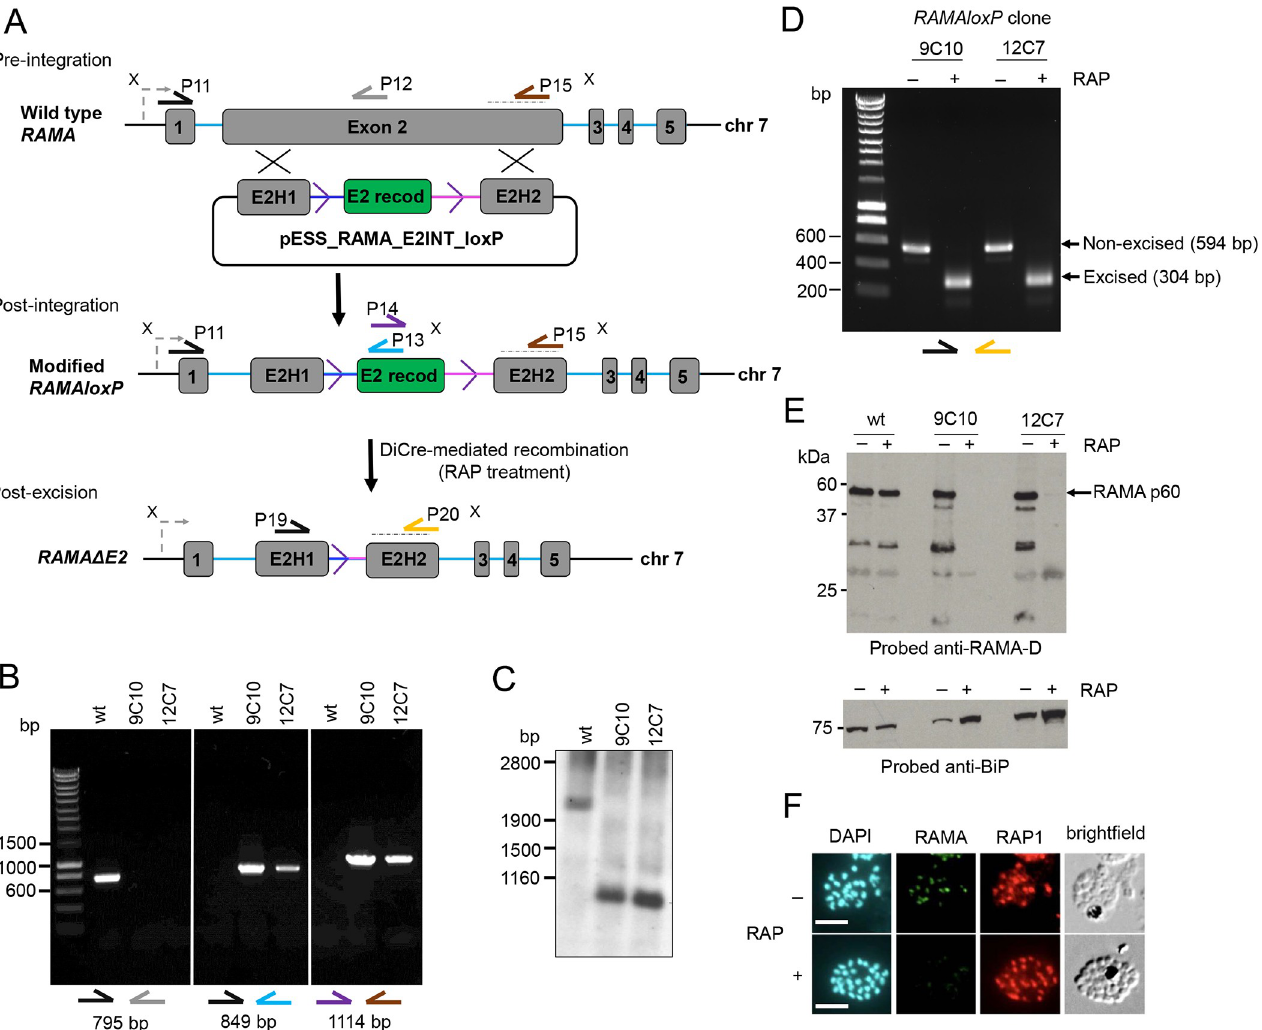
Fig 1. Conditional disruption of the P . falciparum RAMA gene. (A) The RAMA gene (PlasmoDB PF3D7_0707300) comprises 5 exons (numbered grey boxes; not to scale) and 4 introns (blue lines). Two AG-AT motifs (splice site junction consensus sequences; [72]in exon 2, separated by 176 bp, were chosen as the location for insertion of two loxP -containing (purple arrowhead) heterologous introns ( SERA2 : loxPint ,blue line; SUB2 : loxPint ,pink line) flanking a recodonised form of the intervening 176 bp coding sequence (E2 recod, green box). The integration sequence, provided on repair construct pESS_RAMA_E2INT_loxP, was inserted by double crossover homologous recombination between homology arms (E2H1 and E2H2), facilitated using Cas9 and sgRNAs encoded on a separate plasmid to generate a targeted double stranded break (see Materials and methods). DiCre-mediated recombination between the loxP sites in the modified RAMAloxP locus was expected to excise the E2 recod sequence, leaving only a single chimeric SERA2 : loxP : SUB2 intron on the chromosome and generating a frame-shift following the first 220 amino acid codons of the RAMA coding sequence. Positions of primers used for diagnostic PCR are indicated (half arrows; see S1 Table for numerical codes and sequences of all primers used in this study), as are XmnI restriction sites (X) used for Southern blot analysis. The grey dotted line indicates the region used for hybridisation of a probe for Southern blot. (B) PCR analysis of RAMAloxP clones 9C10 and 12C7 confirmed the expected gene modification events. Amplicons diagnostic of the wild type locus obtained from parental 1G5DC parasites (wild type; wt) were not amplified from the RAMAloxP clones. Primer identities are colour-coded as in panel (A). (C) Southern blot; XmnI-digested genomic DNA from RAMAloxP clones 9C10 and 12C7 was hybridised with a probe specific for the E2H2 sequence. Expected fragment sizes are 2,191 bp (wt) and 1,050 bp ( RAMAloxP ).(D) Diagnostic PCR showing efficient RAP-induced excision of the floxed sequence in the RAMAloxP parasite clones, leading in both cases to the expected decrease in amplicon size from 594 bp to 304 bp. Primer identities are colour-coded as in panel (A). (E) Immunoblots of SDS PAGE-fractionated cycle 0 schizont extracts probed with anti-RAMA-D antibodies (raised against residues 482–758 of the RAMA sequence; [36]). Loss of RAMA p60 expression (arrowed) was almost complete in the RAP-treated RAMAloxP parasites. Similarly-treated 1G5DC schizonts (wt) were analysed in parallel to confirm that RAP-treatment has no effect on RAMA expression in the absence of the RAMAloxP modification. The blots were stripped and re-probed with anti-BiP antibodies as a loading control (lower panels). (F) Representative IFA images demonstrating loss of RAMA expression upon RAP-treatment of RAMAloxP- 9C10 parasites. Cycle 0 schizonts were co-stained with anti-RAMA-D antibodies and the anti-RAP1 monoclonal antibody (mAb) 4F3. 4,6-diamidino-2-phenylindole (DAPI) was used as a DNA stain. The great majority of RAP- treated parasites ( > 99.8% as calculated from exhaustive examination of 1,002 schizonts by IFA) showed no detectable anti-RAMA-D staining, but the RAP1 signal remained unaffected. Scale bars, 5 μ m.